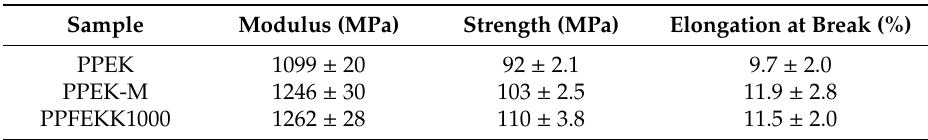
Table 6. Tensile Properties of the PPFEKKs.